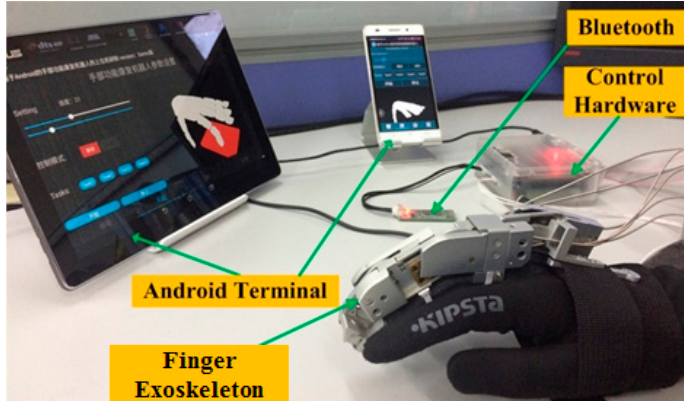
Figure 8. Experimental setup.